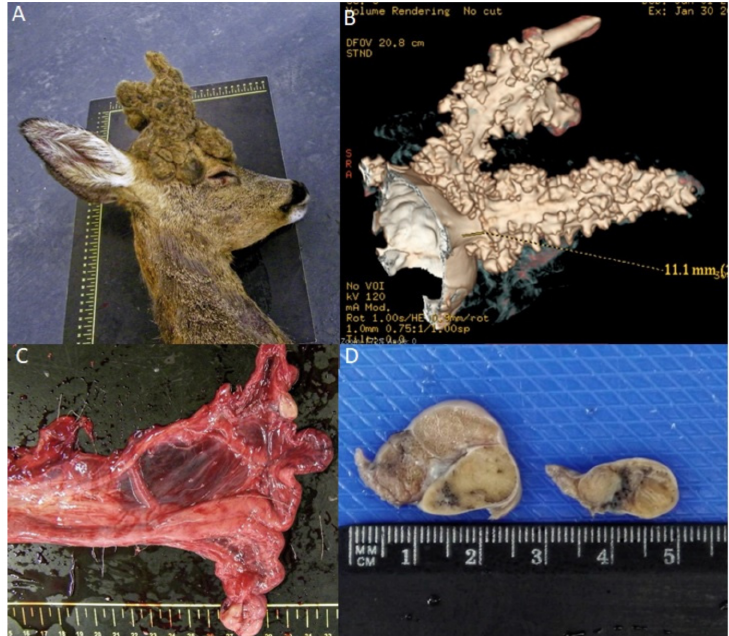
Figure 1. ( A ) Image of the antlers showing retained velvet; ( B ) CT image of the antlers; ( C ) Macro- scopic view of reproductive organs, with two ovoid unilateral gonads; ( D ) the testicle (gonad at left), and the ovotestis (gonad at right), which showed two macroscopic distinct areas.